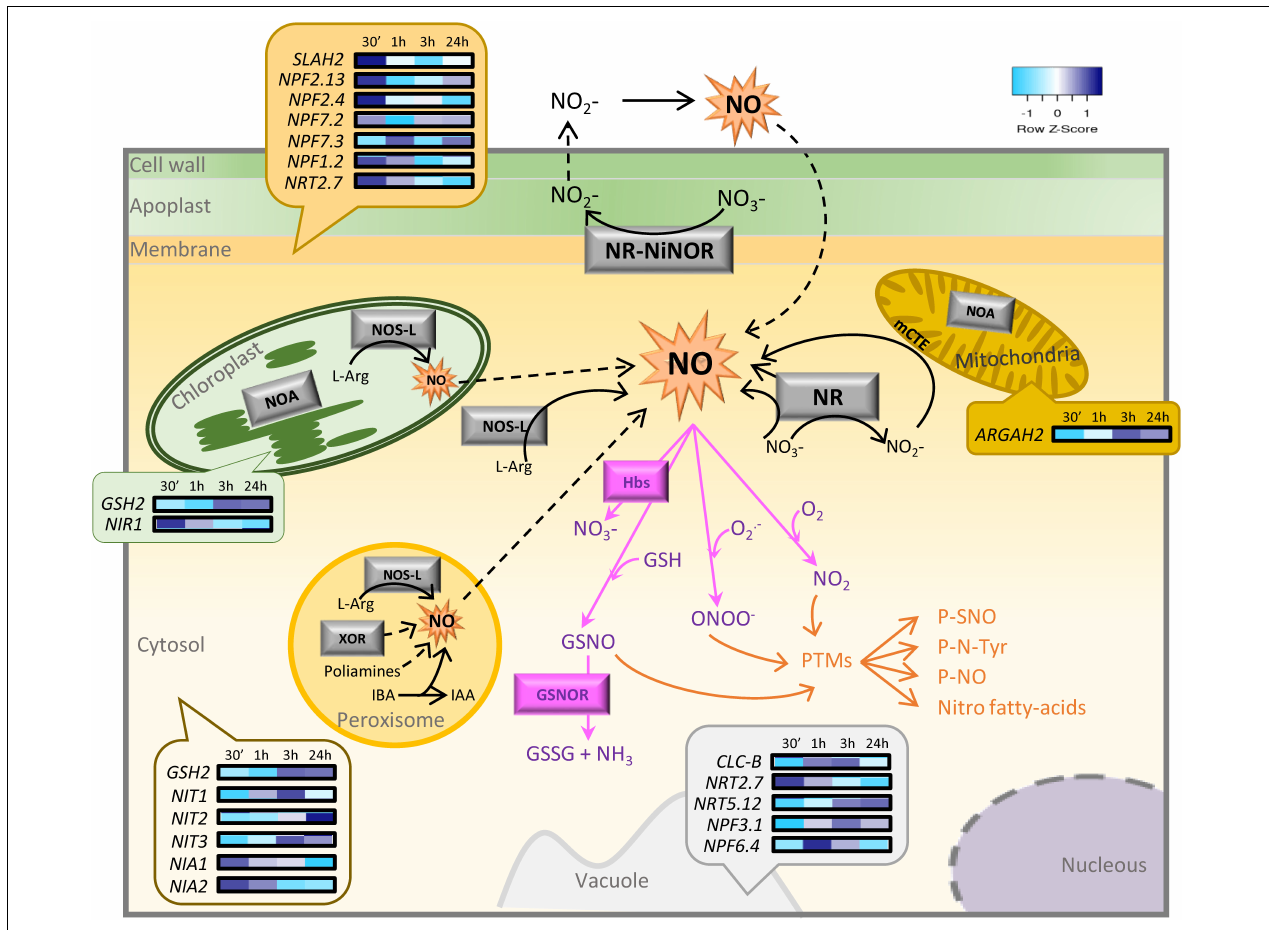
FIGURE 1 | Schematic overview of NO sources and pathways in a plant cell and a heatmap of NO-associated genes expressed in the subcellular locations of A. thaliana after spider mite feeding. The diagram shows the main sources and pathways of NO (black arrows) including both oxidative and reductive pathways, the main scavengers (pink arrows) including superoxide ion, GSH, and hemoglobins, and the main NO mechanisms of action (orange arrows). Discontinued lines represent the mechanisms not experimentally demonstrated. A heatmap showing transcriptomic data of NO-associated genes from A. thaliana at different infestation times (30 min, 1, 3, and 24 h) with T. urticae is comprised within bubbles, positioned over the subcellular compartment where genes are expressed according to SUBA predictions, with a score ≥ 0.5. IAA, indole-3-acetic acid; IBA, indole-3-butyric acid; GSH, glutathione; GSNO, S-nitrosoglutathione; GSNOR, S-nitrosoglutathione reductase; Hbs, hemoglobins; L-Arg, L -arginine; mETC, mitochondrial electron transport chain; NR, nitrate reductase; NO, nitric oxide; NOS-L, nitric oxide synthase-like; NOA, NO-associated protein; P-NO, nitrosylated protein; P-N-Tyr, nitrated protein; P-SNO, S-nitrosylated protein; PTMs, post-translational modifications; XOR, xanthine